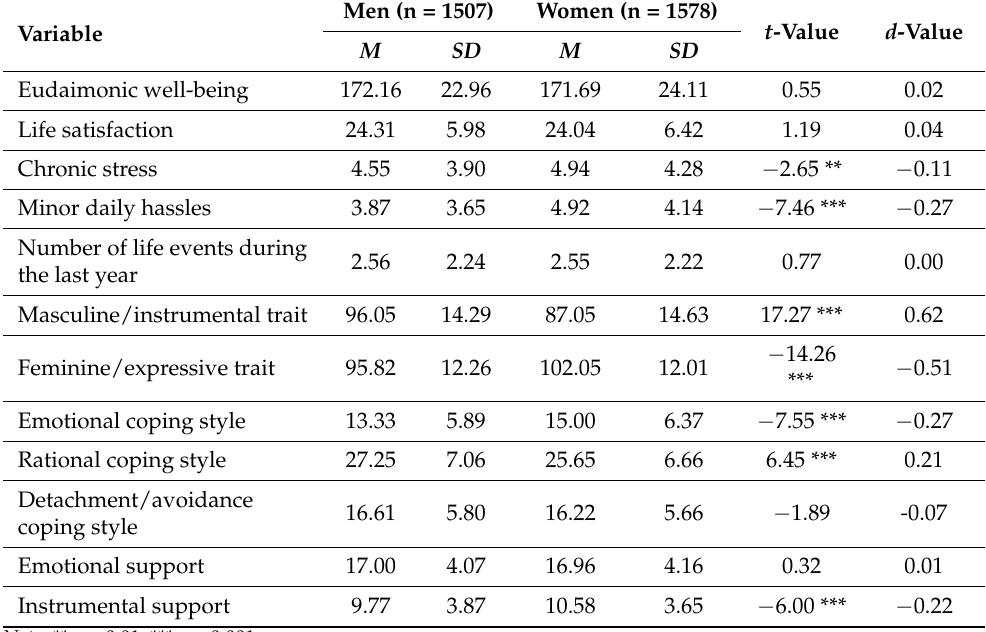
Table 2. Mean ( M ), standard deviation ( SD ), and comparisons for men and women groups for well-being, stress, masculine/instrumental and feminine/expressive traits, coping styles, and social